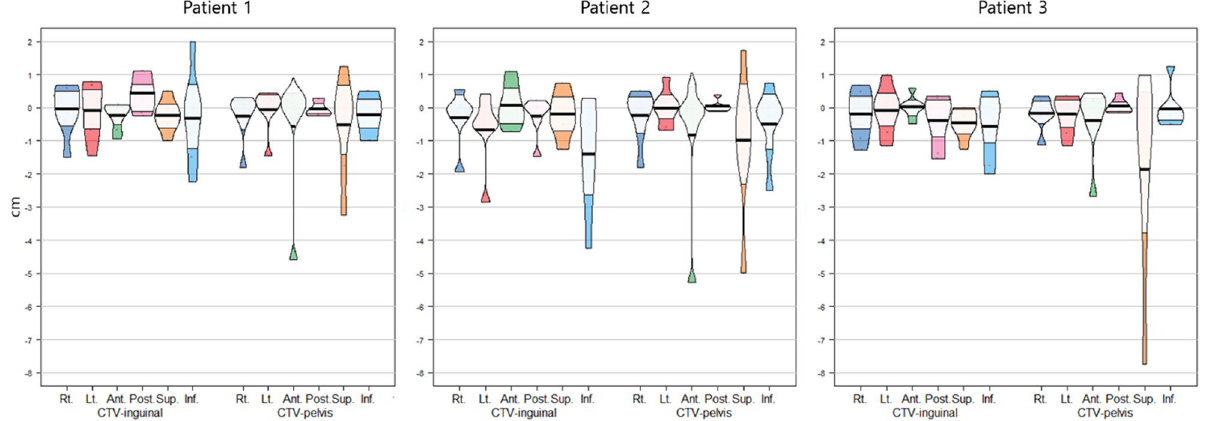
Figure 2. Pirateplot of differences of borders in 6 directions between each CTV and STAPLE generated CTV with confidence level of 80% (CTV-80). Positive values represent that border of each CTV is larger than CTV-80 in each direction. Plots were generated using R software version 3.6 (R Core Team, 2020. R: A language and environment for statistical computing. R Foundation for Statistical Computing, Vienna, Austria. https ://www.R- proje